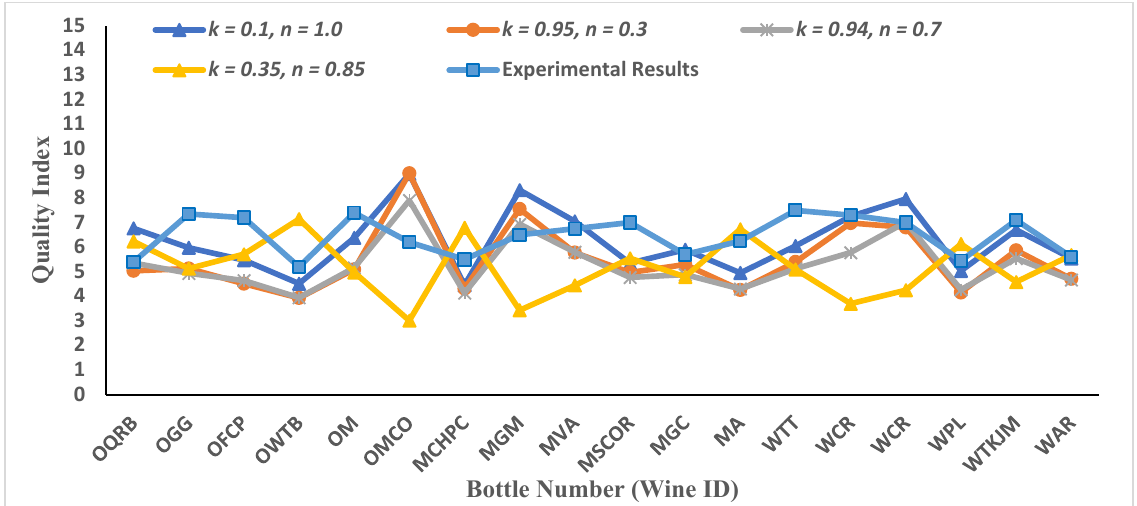
Figure 8. Wine quality results for case study 2 for data3. As explained in Equation (9), we assumed n 2 = α = n . Different values of the parameter k are considered in contrast with the value of k taken as unity in Figure 5. Results obtained in this case study are denser as compared to case study 1. This dataset is quite different as compared with data2, and a few outliers are also there. Though any concrete results cannot be obtained from the predicted values, results are comparable and clearly suggest providing the balance weightage to each